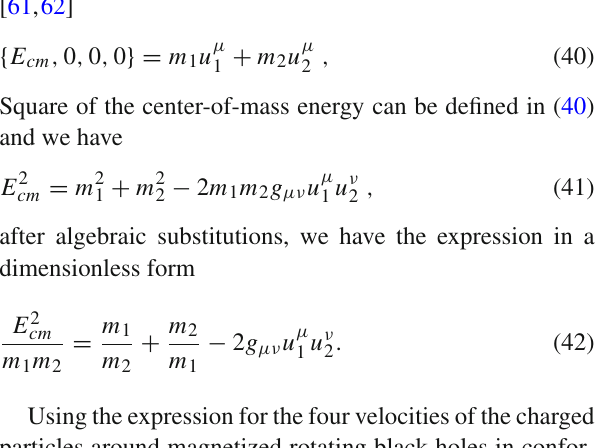
Fig. 14 Radialdependenceoftheeffectivepotentialofradialmotionof achargedparticlearoundrotatingquasi-Kerrblackholeintheequatorial plane. The figures correspond to the case of a. without external mag-